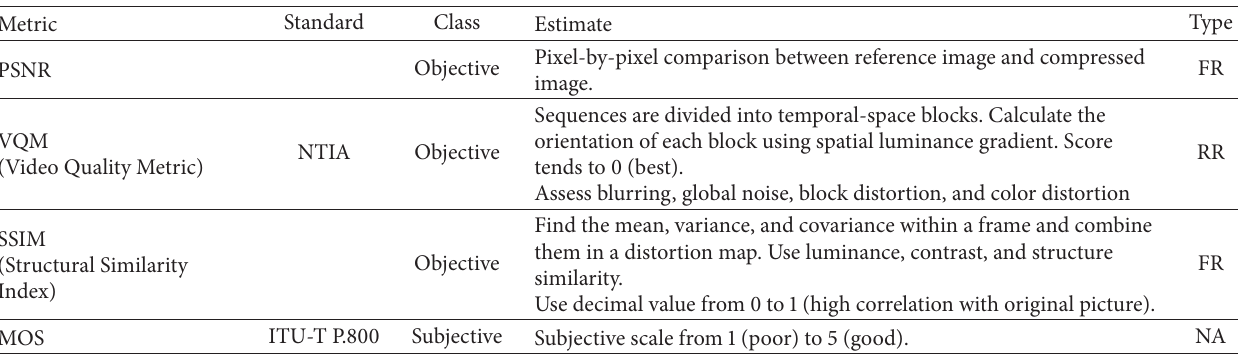
Table 1: Comparative table of the main QoE metrics.